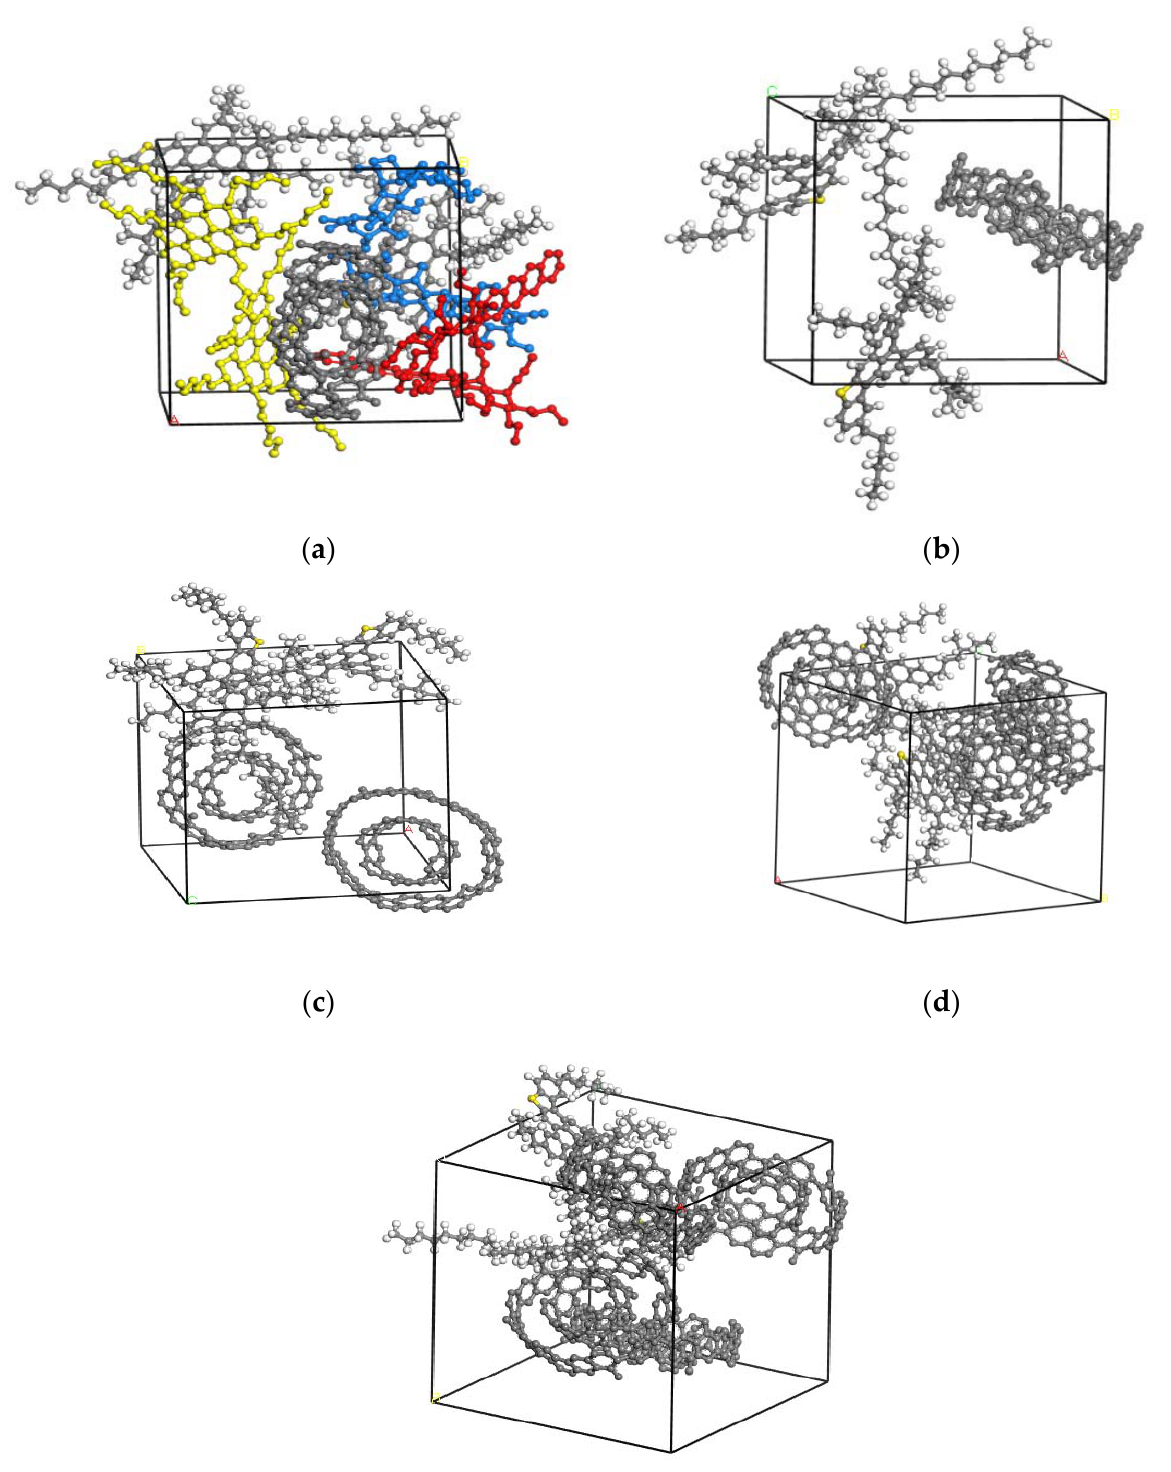
Figure 3. The aggregate or collective-solid states of the MWCNTs-MA matrix: ( a ) 1.0% MWCNTs; ( b ) 1.0% MWCNTs deleted resins, saturates and aromatics; ( c ) 1.5% MWCNTs deleted resins, saturates and aromatics; ( d ) 2.0% MWCNTs deleted resins, saturates and aromatics; and ( e ) 2.5% MWCNTs deleted resins, saturates and aromatics.